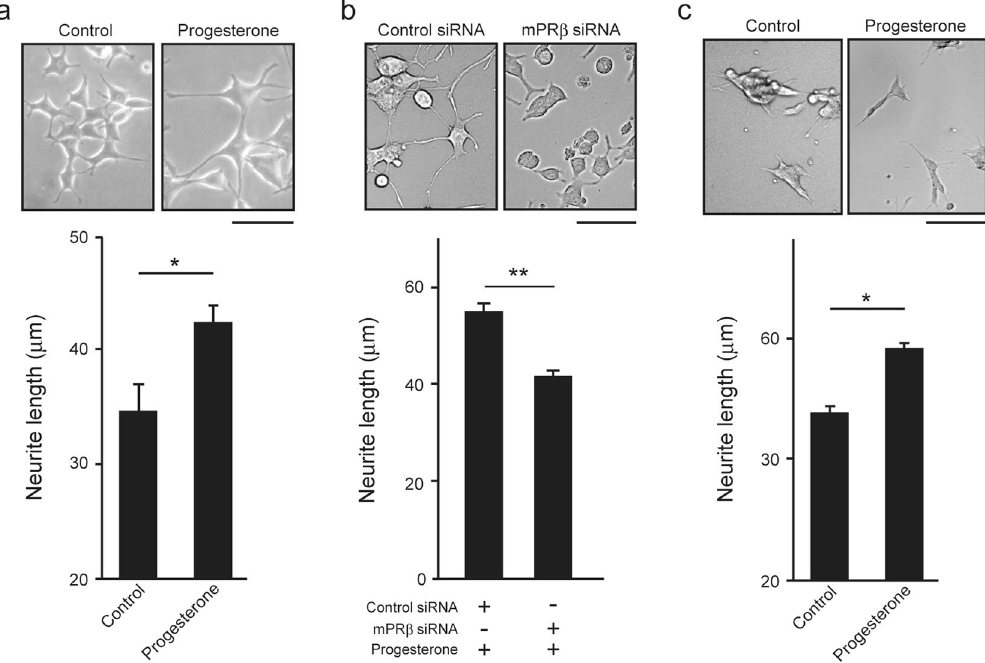
Figure 2. Effects of progesterone on neurite outgrowth via mPR β in NGF-induced neuronal PC12 cells. ( a ) Effects of progesterone on neurite outgrowth. After 24 h in culture, PC12 cells were treated with NGF (50 ng/ mL) or co-stimulated with NGF and progesterone (10 μ M) for 3 days. (n = 3). Scale bar = 100 μ m. ( b ) After being treated with Control siRNA or mPR β siRNA, PC12 cells were cultured for 3 days in DMEM containing 1% FBS, NGF (50 ng/mL) and progesterone (10 μ M) (n = 3). ( c ) Effects of progesterone on neurite outgrowth. After 24 h in culture, SH-SY5Y cells were treated with NGF (50 ng/mL) or co-stimulated with NGF and progesterone (10 μ M) for 12 h. (n = 4–8). Scale bar = 100 μ m. The graph reports the average length of neurites. Results are presented as means ± S.E.M. * p < 0.05, ** p < 0.01. Statistical analysis was performed by using Student’s